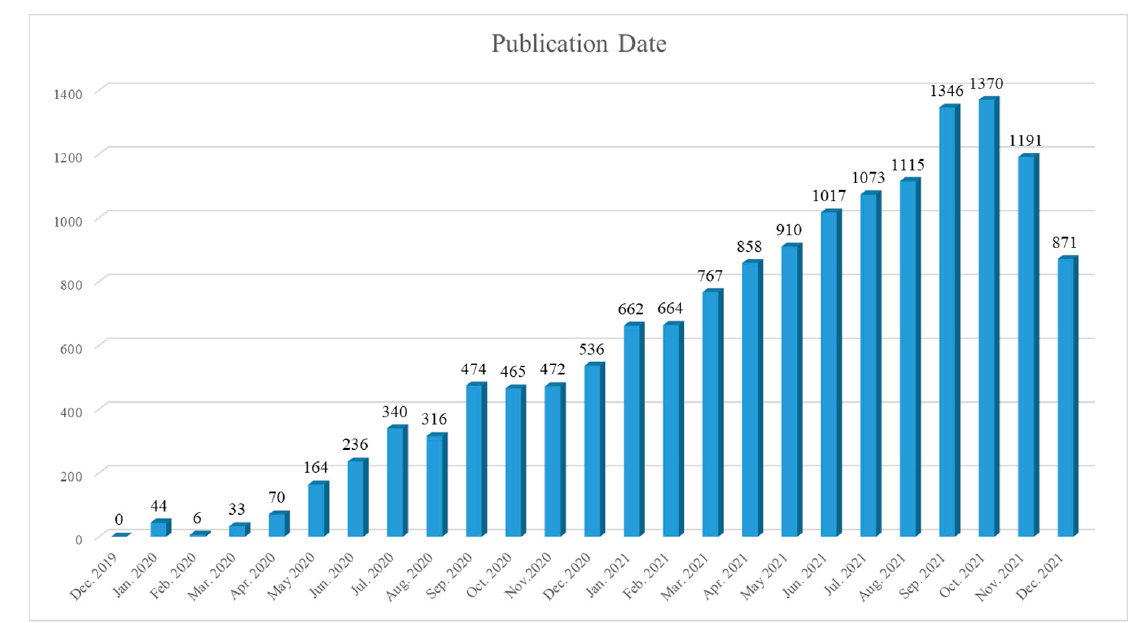
Figure 4. The overall trend of publications on COVID-19 vaccine from December 2019 to December Figure 4. 2021.